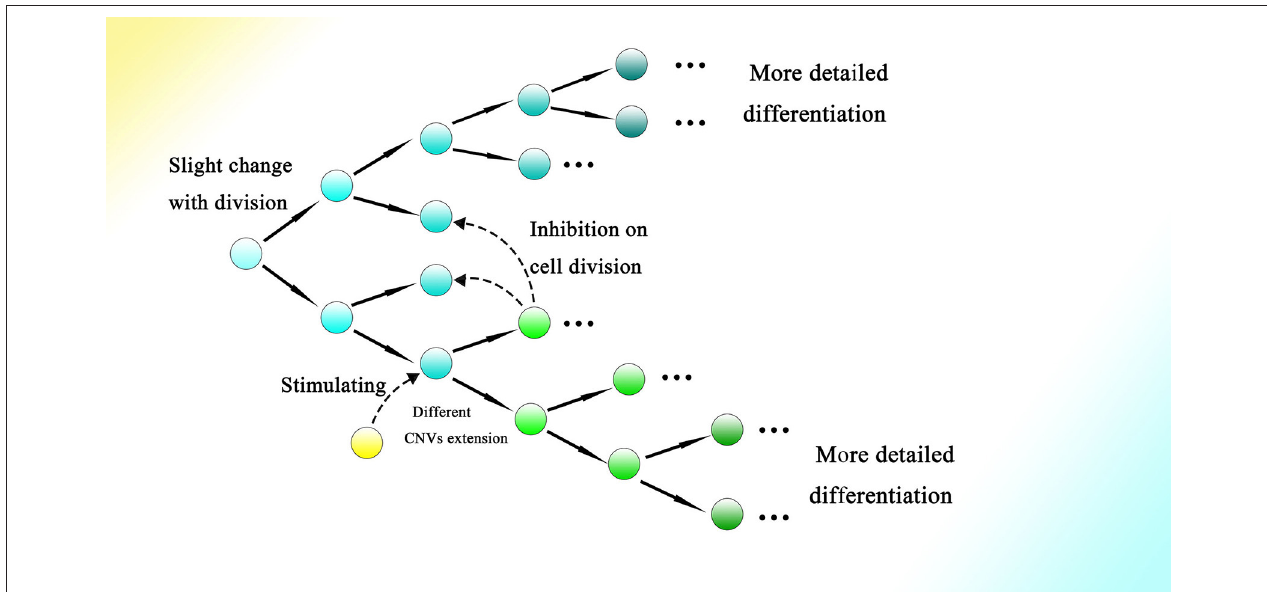
FIGURE 8 | Cell division could bring about gradual genome change and thus differentiation during embryogenesis. The genome of the cell would be changed slightly with every division. The occurrence of division and the direction of differentiation are affected by adjacent cells or other external effects. The gene expression of cells could be influenced by adjacent cells, resulting in changes in CNVs extension style and therefore an altered direction of differentiation. Finally, as the cell divides, detailed and intricate differentiation would be